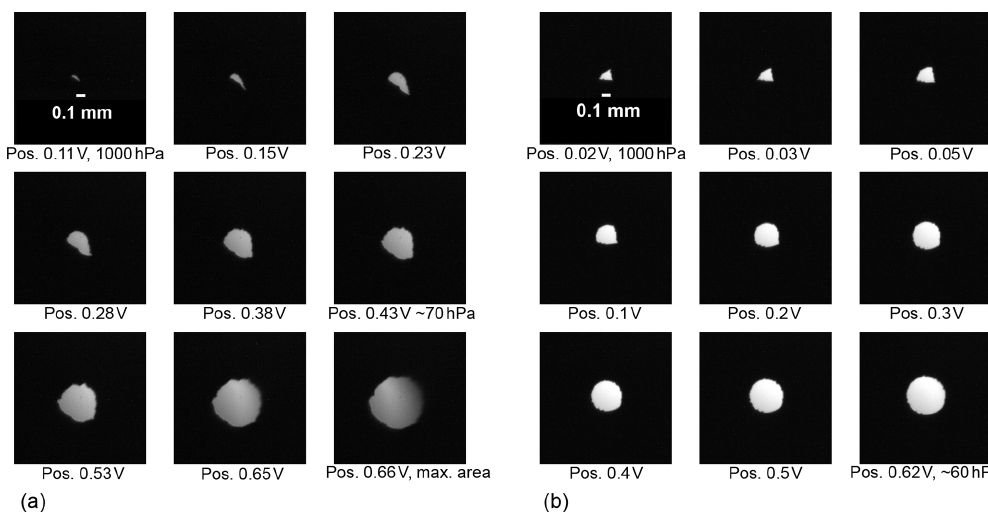
Figure 5. Microscope photographs of the O-ring aperture inside a backlit CPI device at different levels of pinching. The amount of pinching is recorded by a voltage output (see captions) of an optical distance sensor installed on the CPI’s mechanics (Fig. 3). From the additionally logged inlet pressure during flight or laboratory experiments, the pinching position can be associated with a given inlet pressure. Exemplarily, pressure values of the desired limits (1000 to 60hPa or 70hPa) are denoted for corresponding photographs. Panel (a) shows the initial setup with a commercial O-ring having dimensions of 0.8mm × 2mm. As seen in the minuscule (backlit) aperture area for sea level pressure (1000hPa), warping of the opening’s shape and thus of the sample flow path can lead to high particle losses. Panel (b) shows the custom- made optimized O-ring design with an inner diameter of